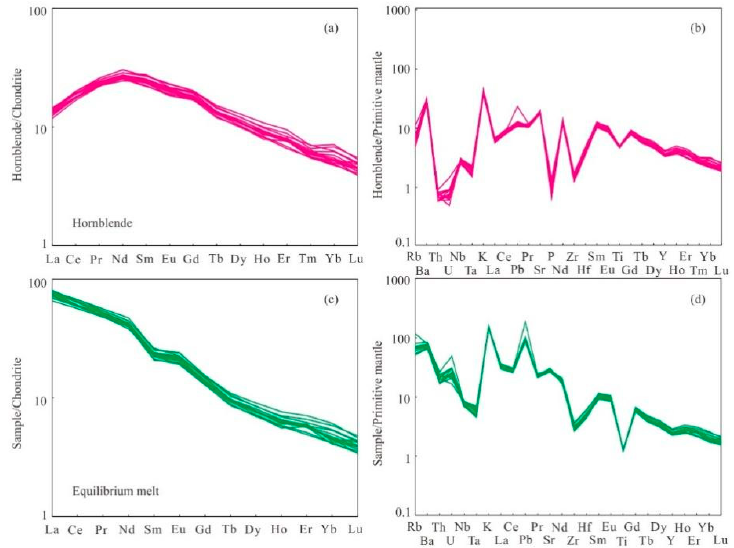
Figure 5. Chondrite-normalized REE patterns ( a , c ) [46] and primitive mantle-normalized trace element spidergrams ( b , d ) [48] of hornblendes from the hornblendite and their equilibrium melt.